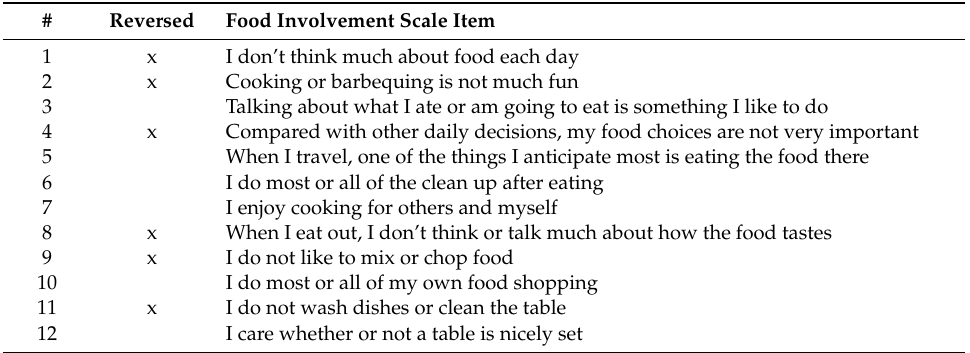
Table A2. Overview of the di ff erent items included in the food involvement scale (FIS, [28]) and whether the score for each item should be reversed during calculation of the final FIS score. Participants are asked to indicate how much they agree with the statement in each item on a 7-point scale with labeled endpoints named disagree strongly to agree